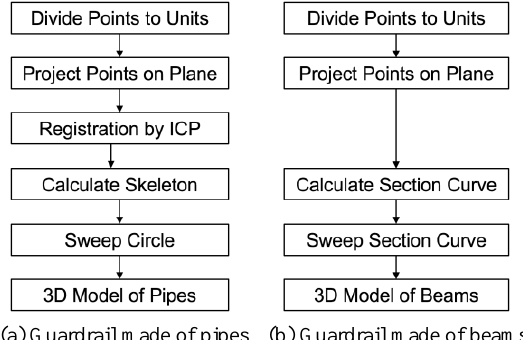
(a) Guardrail made of pipes (b) Guardrail made of beams Figure 4. Process of shape reconstruction Figure 5. Extraction of roadside